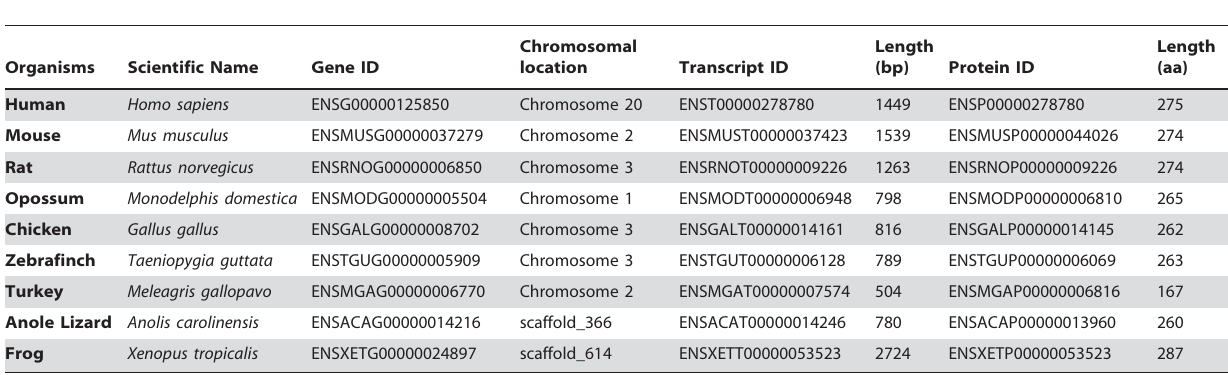
Table 2. List of OVOL2 genes from selected vertebrate genomes, identified from Ensembl database release 58 (May 2010).